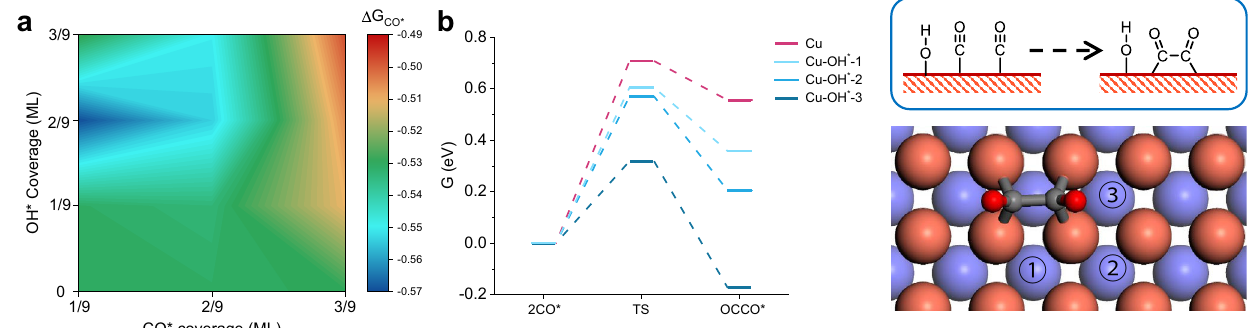
Fig. 1 | DFT calculations. a CO adsorption energy on Cu(100) surface with dif- ferentOHandCOcoverage. b Freeenergypro fi lesofCOdimerizationonCu(100) with and without adsorbed OH. Different positions of OH * denoted as Cu-OH * -1,